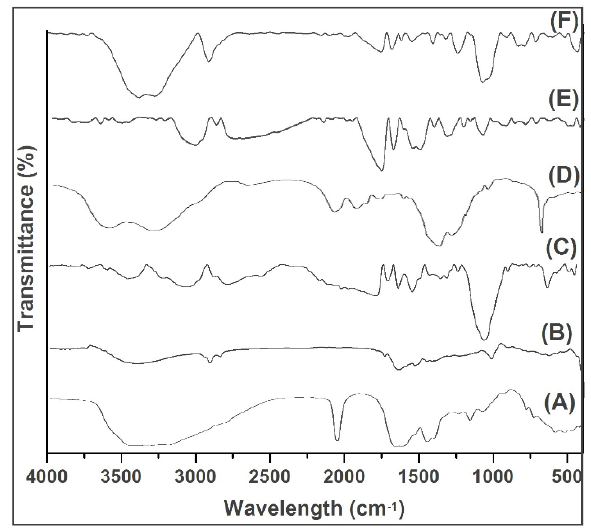
Figure 2. FTIR spectra of ( A ) Reference keratin, ( B ) Extracted keratin, ( C ) PVA, ( D ) GS, ( E ) scaffold (1:3), and ( F ) scaffold (1:4).